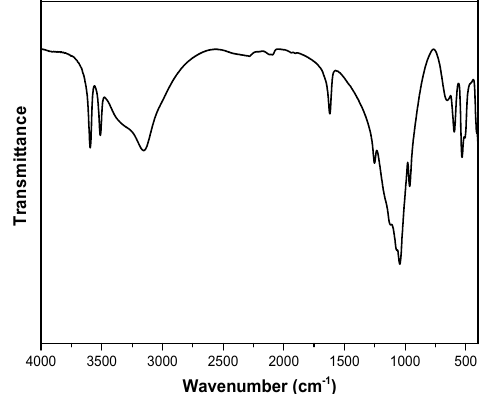
Figure 2. Fourier transform infrared (FTIR) spectrum of ZrP.